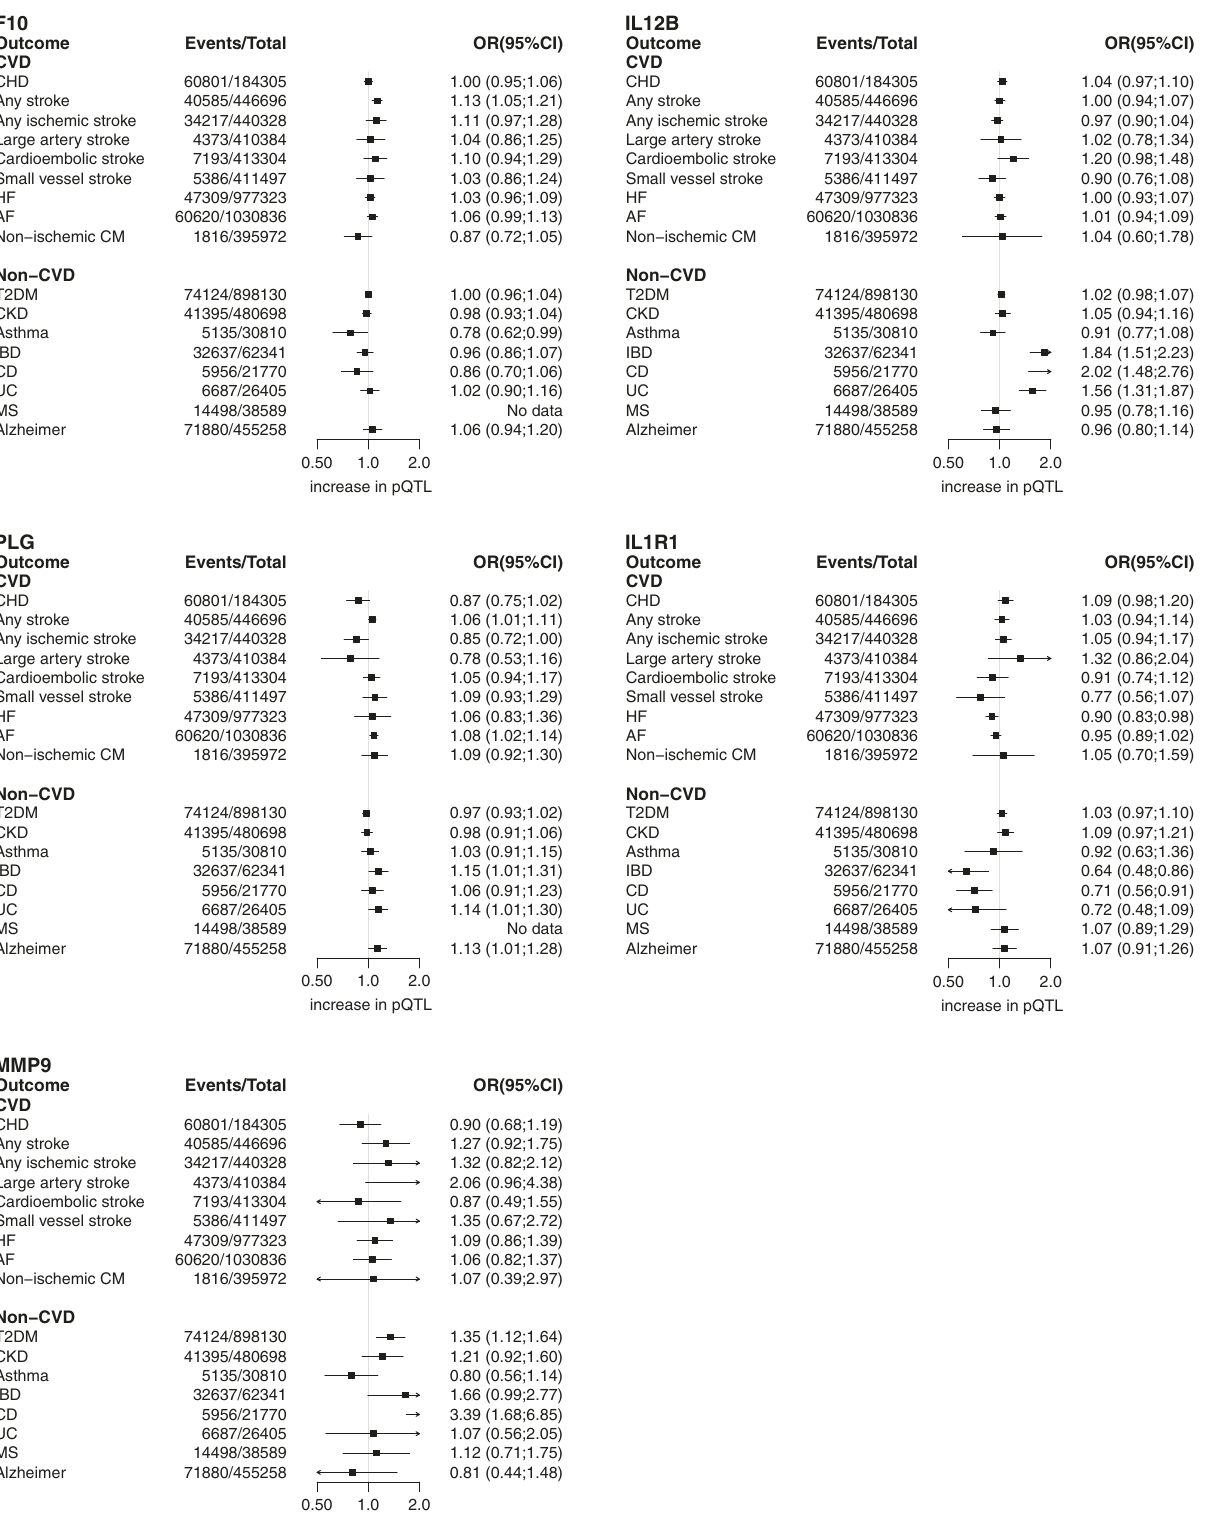
Fig. 6 A pQTL based drug target MR phenome wide scan. Results are presented as odds ratios with 95% con fi dence intervals (horizontal lines), positioned in the protein increasing direction. The total number of events and sample size are provided in the forest